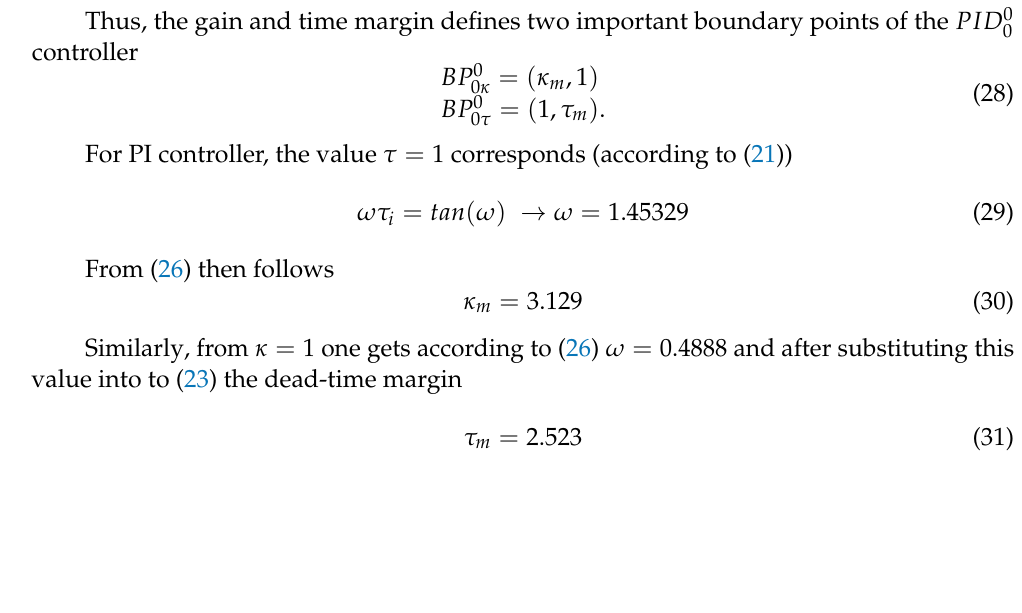
Figure 1. Stability borders of the nonfiltered PID 0 values of τ e = T e / ( T dp + T e ) , T dp = 1 and the average-residence-time tuning equivalence T f = T e / n , n = 1,2; + denoting the nominal